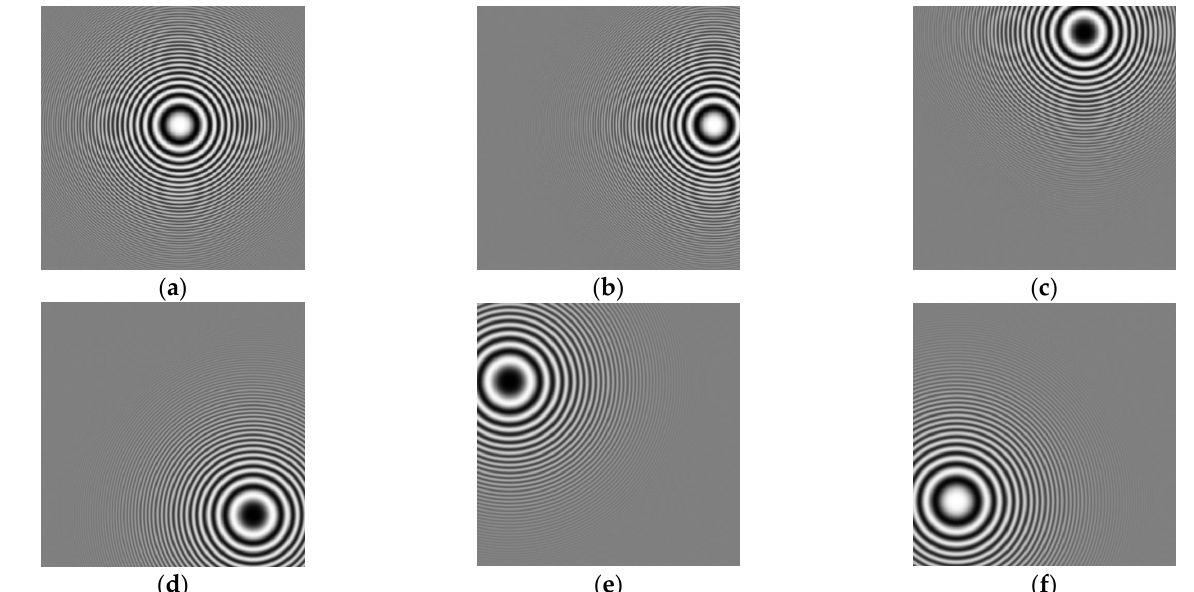
Figure 7. The separated and reconstructed fringe patterns ( a – f ) from the mixture signal shown in Figure 3a.